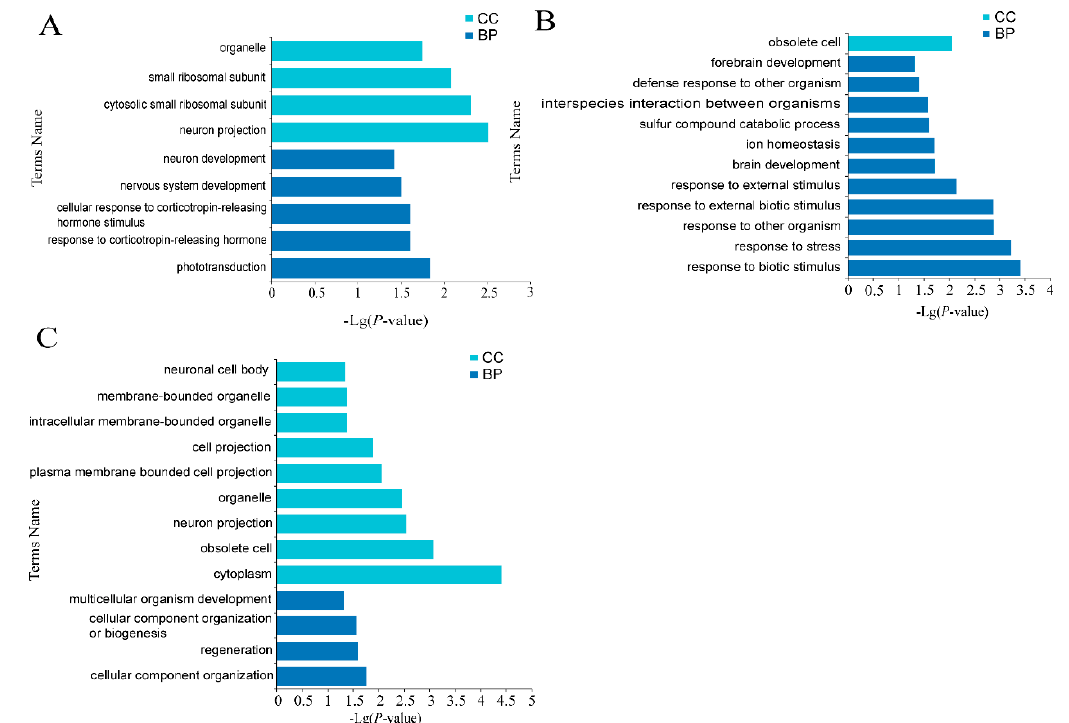
Figure 4. Enrichment analysis of hypothalamus mRNAs. ( A ) Enriched GO terms of luteal stage, ( B ) Enriched GO terms at proestrus stage, ( C ) Enriched GO terms at estrus stage. Different bar chart colors represent different items. Dark blue represents BP, light blue represents CC, and orange indicated MF.